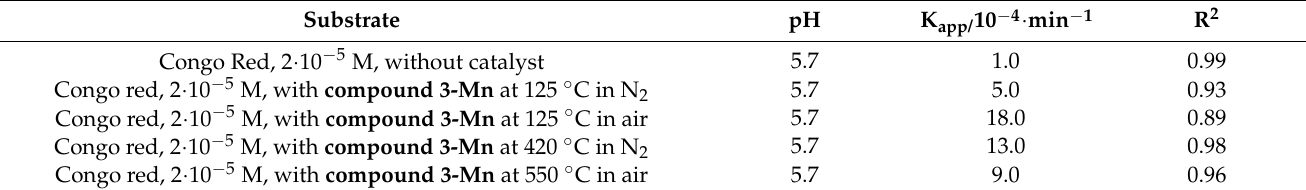
Table 7. Photocatalytic parameters in the decomposition of methyl orange and Congo red with in- termediates forming in different conditions.